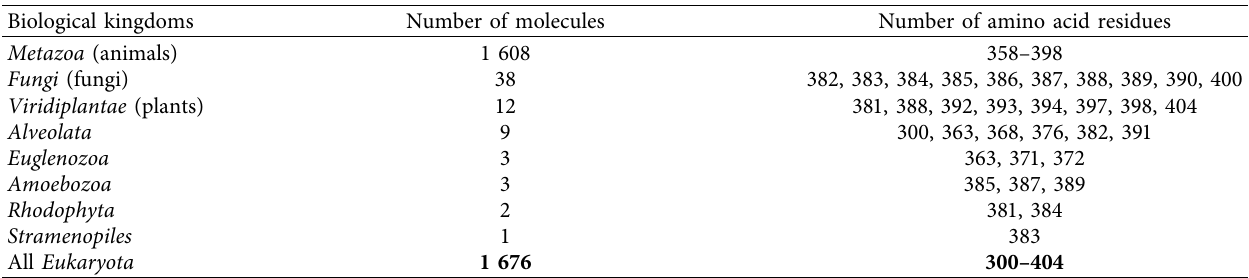
Figure 2: Distribution of the number of cytochrome b molecules, according to data from the Swiss-Prot database on the number of amino acid residues in various biological domains. The data for eukaryotes are presented at two scales of the ordinate—a truncated one, revealing small peaks throughout the entire region where lengths of amino acid residues exist, and a full one, where the entire maximum peak of the distribution is visible. Table 2: Content of the number of cytochrome b amino acid sequences in the Swiss-Prot database in various biological kingdoms of the eukaryote ( Eukaryota )